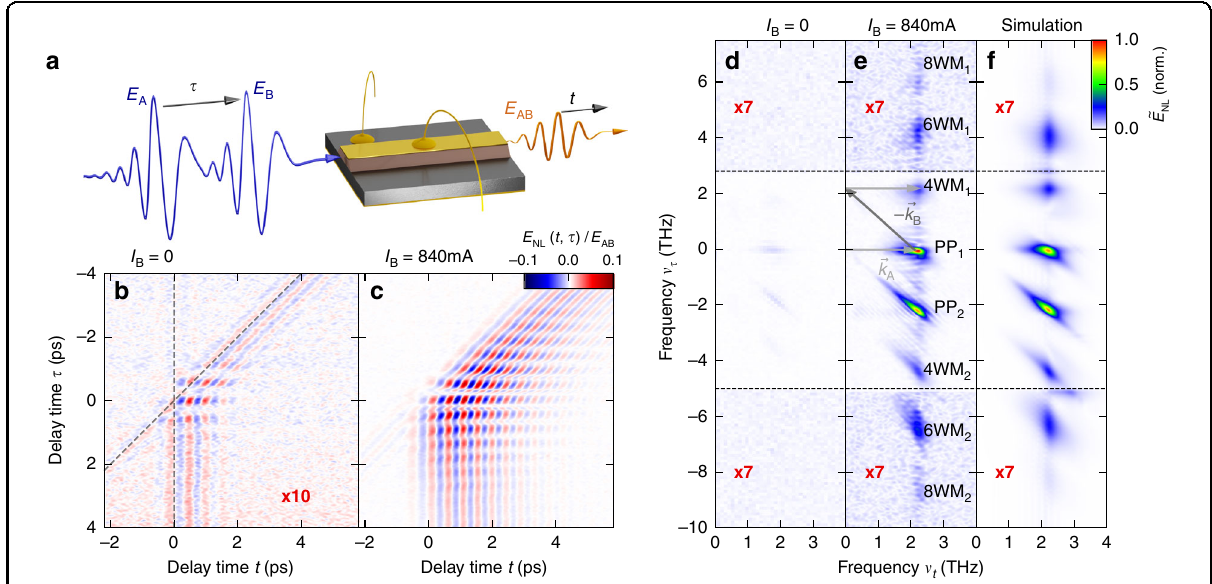
Fig. 2 Field-resolved 2D THz spectroscopy of a free-running QCL. a Experimental arrangement. The THz-waveforms E A and E B (blue) are focused onto the QCL facet and the transmitted waveform ( E AB , orange) is detected electro-optically. b Electric fi eld emitted by the nonlinear polarization, E NL ( t , τ ), of the unbiased QCL as a function of the delay times t and τ . The electric fi eld is multiplied by a factor of 10 and color-coded as in c . c E NL ( t, τ ), as in b , but for biased QCL with a current of I B = 840 mA. d 2D-amplitude spectrum ~ E NL ν t ; ν τ ð Þ of the nonlinear response ( I B = 0) in b . The spectrum is multiplied by a factor of 7 for ν τ < − 5 THz and ν τ > 2.8 THz and color-coded as in e . e 2D-amplitude spectrum ~ E NL ν t ; ν τ ð ( I B = 840 mA) in c . For better visibility of the 6WM and 8WM signals, the corresponding part of the spectrum is multiplied by a factor of 7. f Corresponding simulated 2D-amplitude spectrum ~ E NL ν t ; ν τ